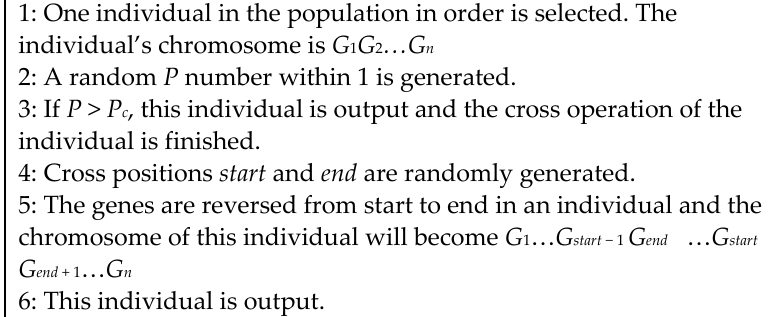
Figure 20. The mutation operation.